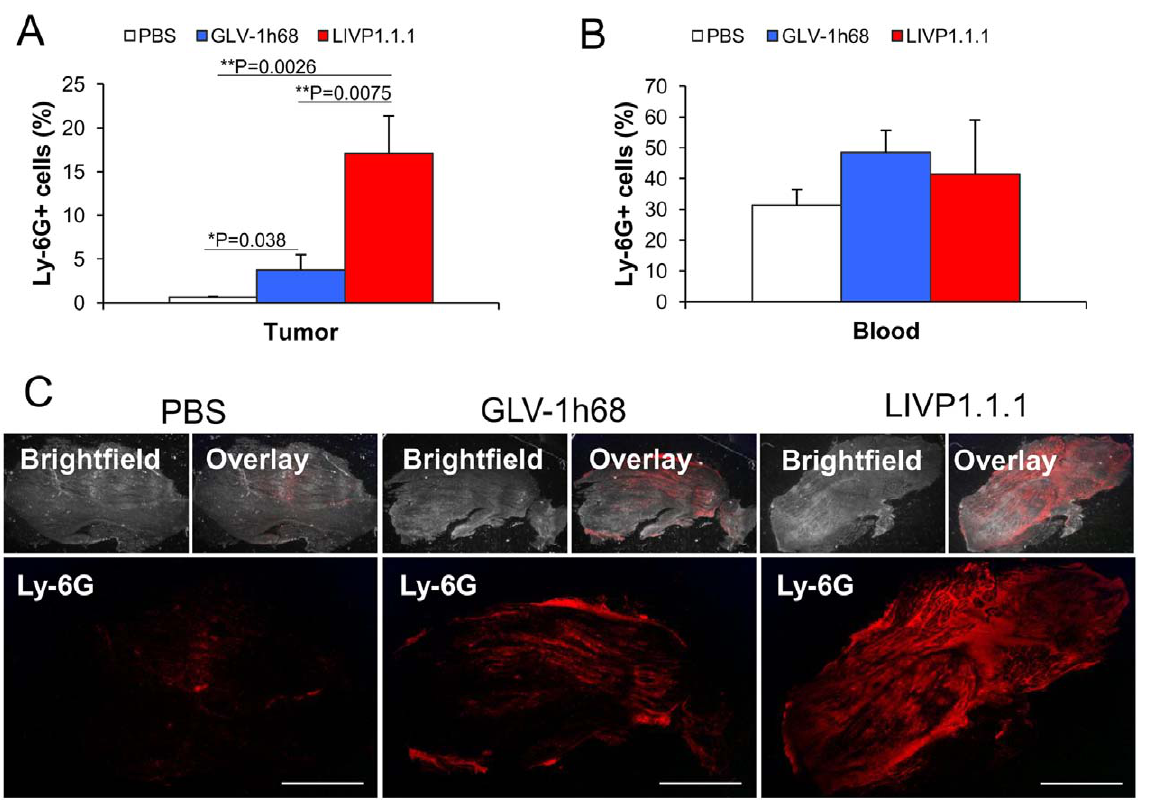
Figure 7. Presence of Ly-6G-positive cells (neutrophils) in virus-infected and non-infected STSA-1 xenografts at 7 dpvi. ( A, B ) Percentage of Ly-6G-positive cells (neutrophils) in tumors ( A ) and in peripheral blood ( B ) of STSA-1 xenografts 7 days after GLV-1h68-, LIVP1.1.1- or PBS-treatment. Experiments were done twice with at least 3 mice per group. The data are presented as mean values + / 2 standard deviations. The statistical significance was analyzed using two-way ANOVA followed Bonferroni post-test (** P , 0.01, *P , 0.05). ( C ) Immunohistochemical staining of Ly-6G-positive cells (neutrophils). Cryosections (10 m m-thick) of tumors were labeled with anti-Ly-6G antibody specfic for neutrophil granulocytes (red). In addition, bright-field transmission images (BF) and overlays of Ly-6G signals and transmission images (bright-field) are shown. Scale bars, 3 mm.